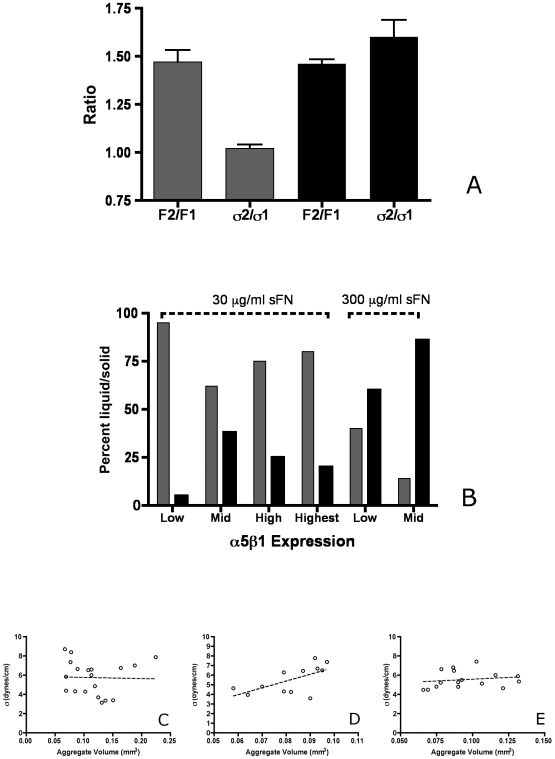
Evaluation of aggregate mechanical properties.α5β1 integrin-Fn interaction can elicit both viscoelastic liquid and elastic solid behavior by compressed aggregates (A). Here we show that for CHO cells transfected to express Mid levels of α5 integrin and incubated in 30 µg/ml sFn, some aggregates exhibit liquid-like behavior, where σ2/σ1 = 1 and is significantly less than F2/F1 (grey bars), whereas others exhibit elastic behavior, where the ratio of σ2/σ1approaches that of F2/F1 (black bars), (two-proportion z test, α = 0.05). Relative percentage of liquid and elastic aggregates as a function of α5β1 receptor expression and sFn concentration (B). Aggregates incubated in 30 µg/ml sFn, irrespective of α5β1 expression, displayed a preponderance of liquid behavior, (grey bars) whereas those incubated in 300 µg/ml sFn behaved predominantly as elastic solids (black bars). Each data set contained 16–20 aggregates. Linear regression analysis of surface tension vs. volume for aggregates expressing various levels of α5β1 integrin. Figures 3C,D, and E represent clones CHO-X5C5 L, H, and HH, respectively. The circles represent data of individual aggregates within each data set. The line is a regression analysis. The data set is for aggregates displaying liquid-like behavior and was generated for aggregates compressed in standard tissue culture medium. The surface tension of aggregates remained relatively constant over a 5-fold range in volume. Linear regression analysis generated correlation coefficient (r2) values of 0.0009 (Fig. 3C), 0.38 (Fig. 3D), and 0.03 (Fig. 3E) for α5β1 (L), α5β1 (H) and α5β1 (HH), respectively. These r2 values indicate that no statistically significant correlation exists between σ and volume (C–E).